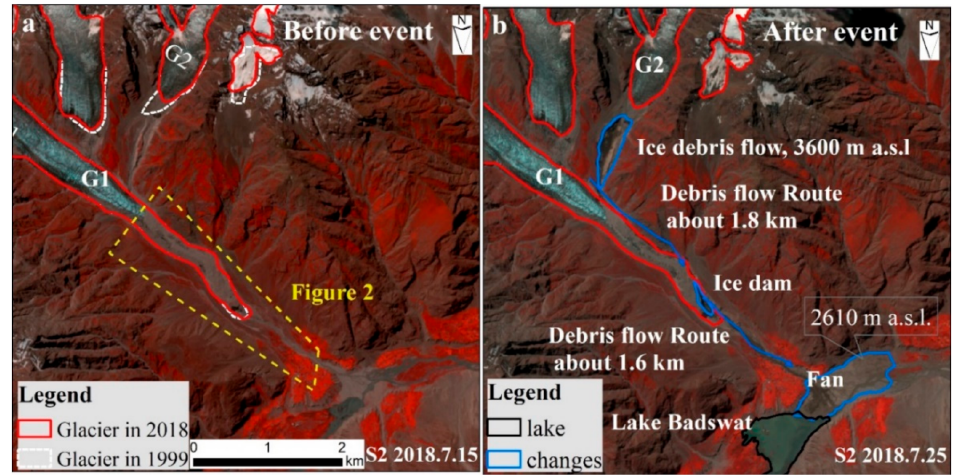
Figure 3. Overview of Sentinel 2 images before ( a ) and after ( b ) the debris flow event (15 July and 25 July 2018,